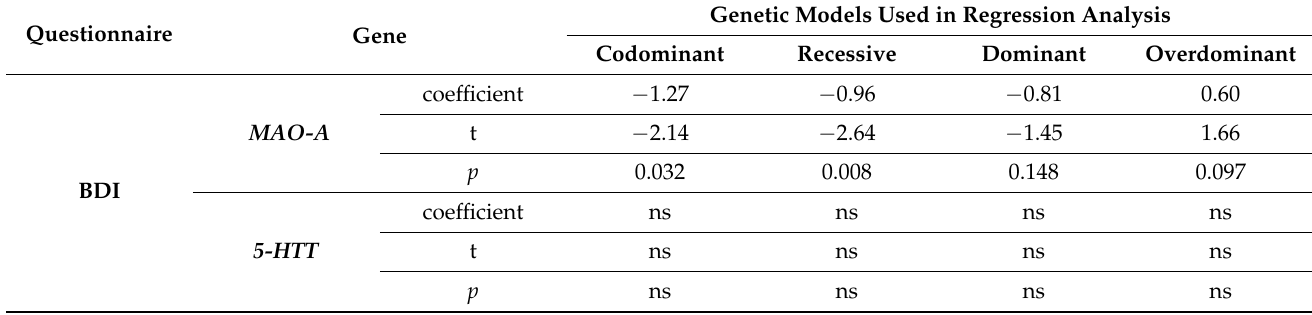
Table 3. Regression analysis between genetic models and depressive symptoms according to the BDI. Questionnaire Gene